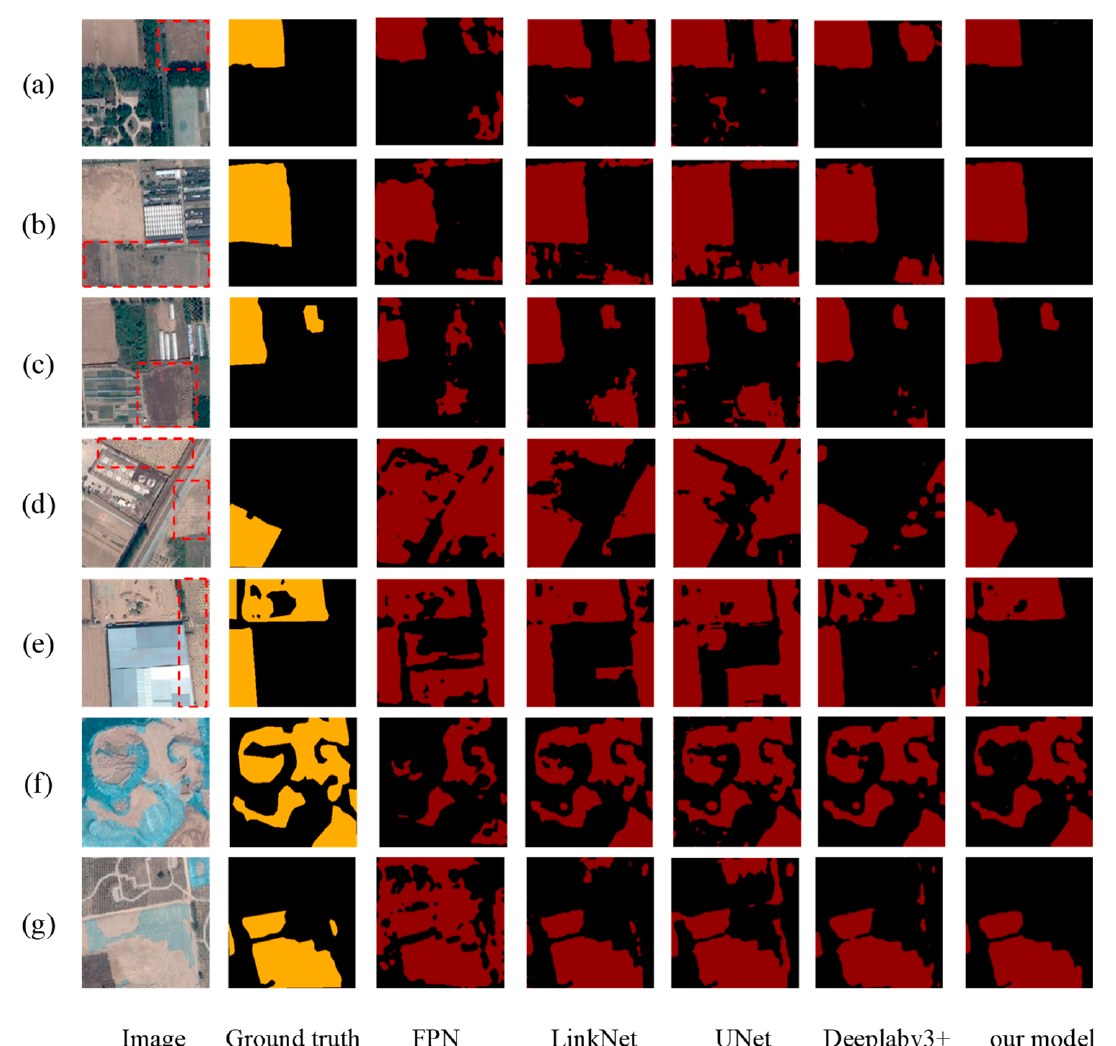
Figure 13. BSL extraction on the BSL test set for the different models: ( a – c ) Interference of BSL-PG; ( d , e ) Interference of BSL-PT; ( f , g ) Interference of dust-proof net covered areas. For FPN-M, UNet-M, LinkNet-M and Deeplabv3+, there were false detections in different degrees for the BSL-PG, labeled by the red, dotted boxes in the images, as